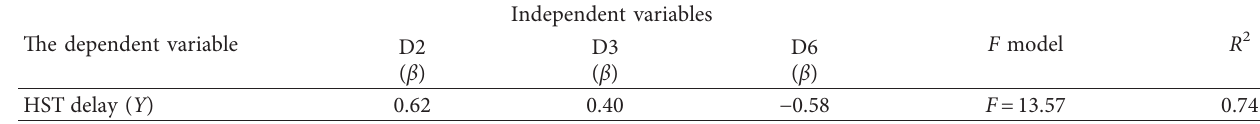
Table 5: Multiple and linear modeling of the relationships between variables affecting the delay. The dependent variable